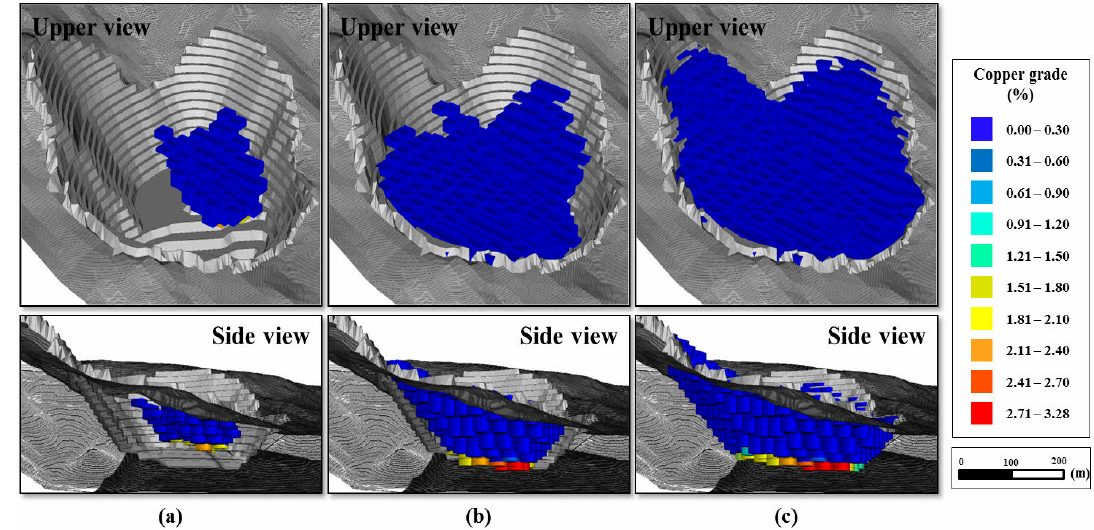
Figure 10. Blocks representing ore reserve above optimal pit boundary. ( a ) Case 1: probability ≥ 90%. ( b ) Case 1: probability ≥ 80%. ( c ) Case 1: probability ≥ 70%.